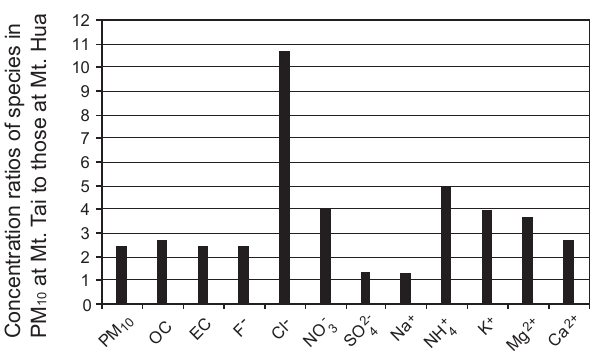
Fig. 3. Temporal variations of TSP and PM 10 concentrations in the Fig. 3 TSP and PM 10 concentrations in the atmospheres atmospheres over Mt. Hua and Mt. Tai during spring 2009. over Mt. Hua and Mt. Tai during spring 2009